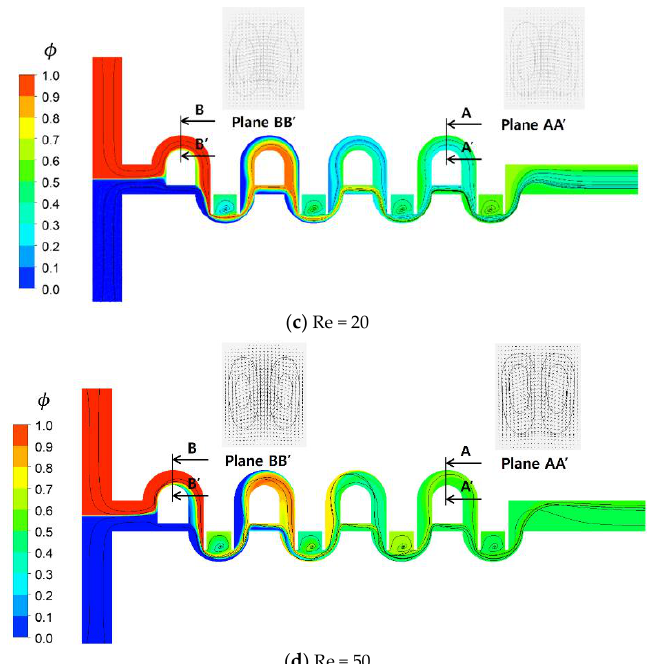
Figure 11. Projected streamlines and contours of the concentration distribution on the plane of the channel half.